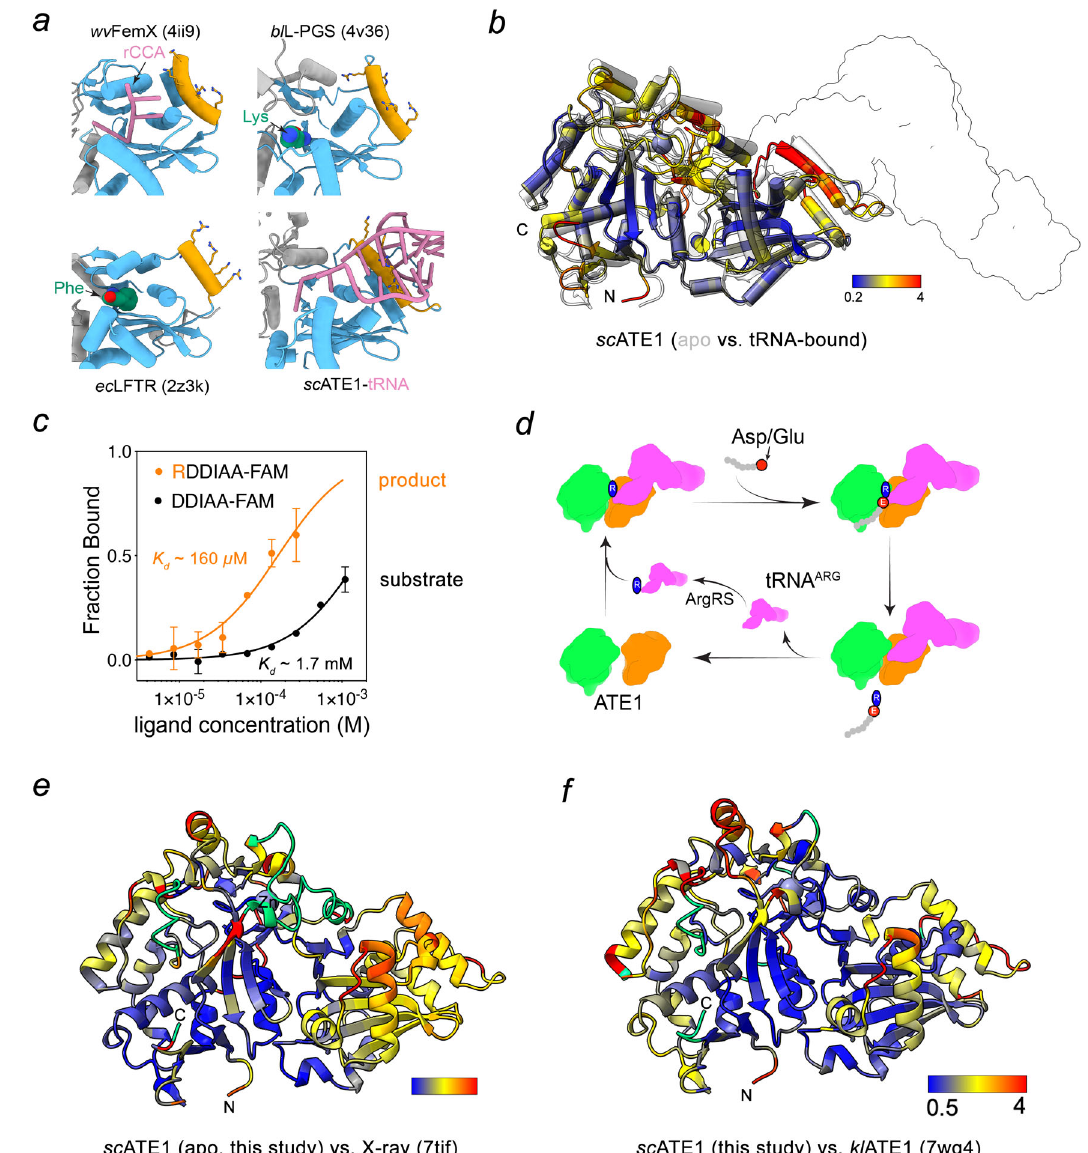
Fig. 6 | Acceptor arm recognition and the proposed mechanism of ATE1- mediatedarginylation. a Ribbon diagrams of the structures of known aminoacyl- tRNA transferases including FemX (PDB: 4II9), ATE1, L-PGS (PDB: 4v36), and LFTR (PDB:2z3k)incomplexwithindicatedligandsshowninstick(violet). α fofATE1and corresponding tRNA interacting helices are colored in yellow, whereas the con- servedGNAT-foldisshowninblue. b OverlayofthestructuresofATE1inapo(light grey)andtRNA-bound(colorbyRMSDcalculatedateachC α )states.Thesurfaceof tRNA is shown in white. The color bar indicates the spectrum representing dis- tances between aligned C α atom pairs, with blue and red specifying 0.2 and 4Å,